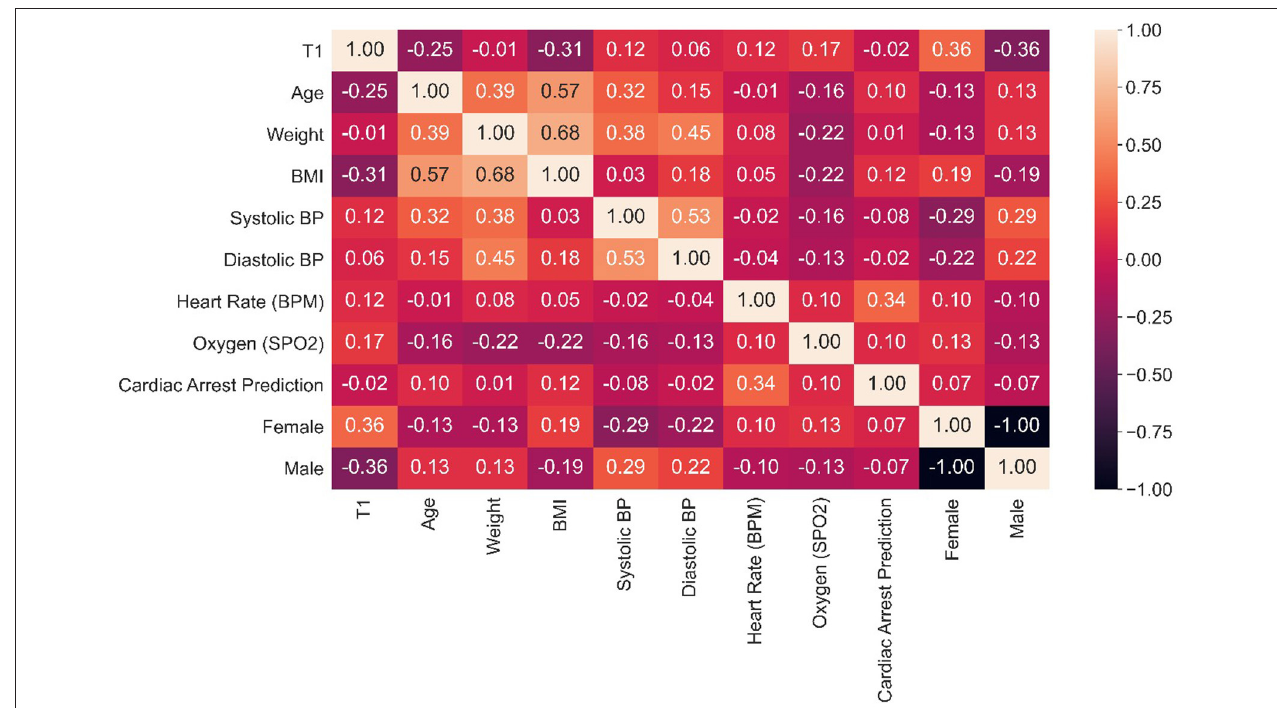
FIGURE 6 | Men/women survival probability graph.